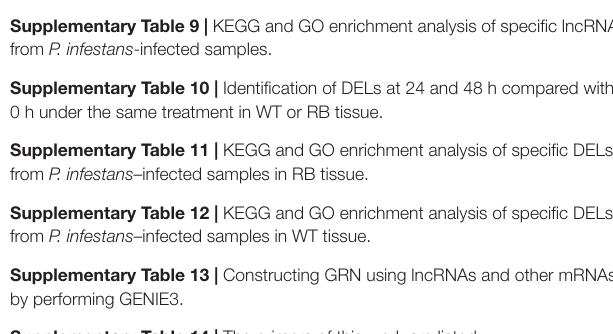
Supplementary Table 2 | Statistics of RNA-seq data. Supplementary Table 3 | Information on Illumina transcriptome-mapped potato reference genome sequence. Supplementary Table 4 | The annotated information on all transcripts. Supplementary Table 5 | The expression level of all transcripts based on TPM. Supplementary Table 6 | Identification of lncRNAs. Supplementary Table 7 | Alternative splicing (AS) event analysis of all lncRNAs. Supplementary Table 8 | Predicting the target genes of lncRNAs.